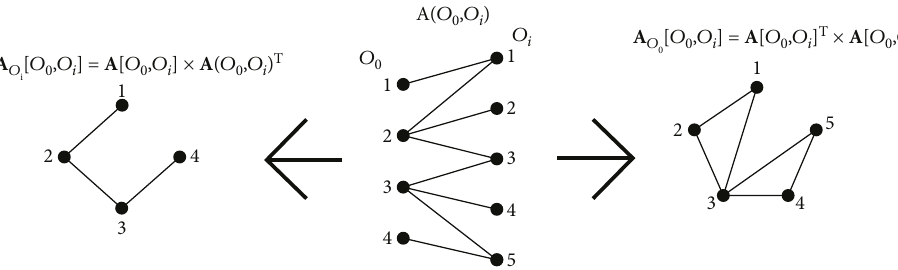
Figure 5: Two di ff erent projections can measure how the neighboring node set generates connections among the